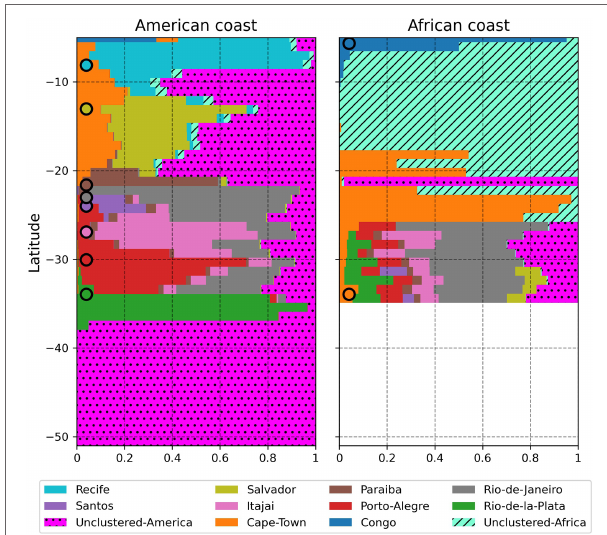
FIGURE 5 | Horizontal bar plot for the posterior probabilities of beached particles ( x -axis) at a specific latitude ( y -axis). The panel on the left shows the probabilities at the American Coast and the panel on the right the probabilities at the African coasts. Each color is associated with a cluster, shown in the legend at the bottom. Each latitude has a corresponding horizontal bar summing the probabilities from the clusters at that latitude to 1. The round markers on the left of each plot represent the latitudes of the clusters. If the marker is on the left panel, the cluster is at the American coast, and if the marker is in the right panel, the cluster is located at the African